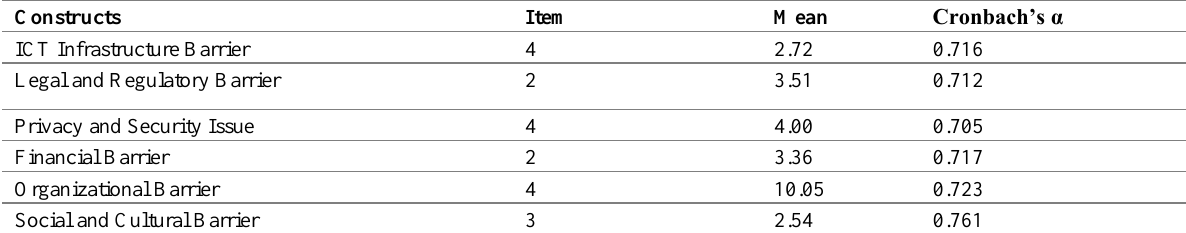
Table 7 : Mean and Scale Reliability of Each Construct